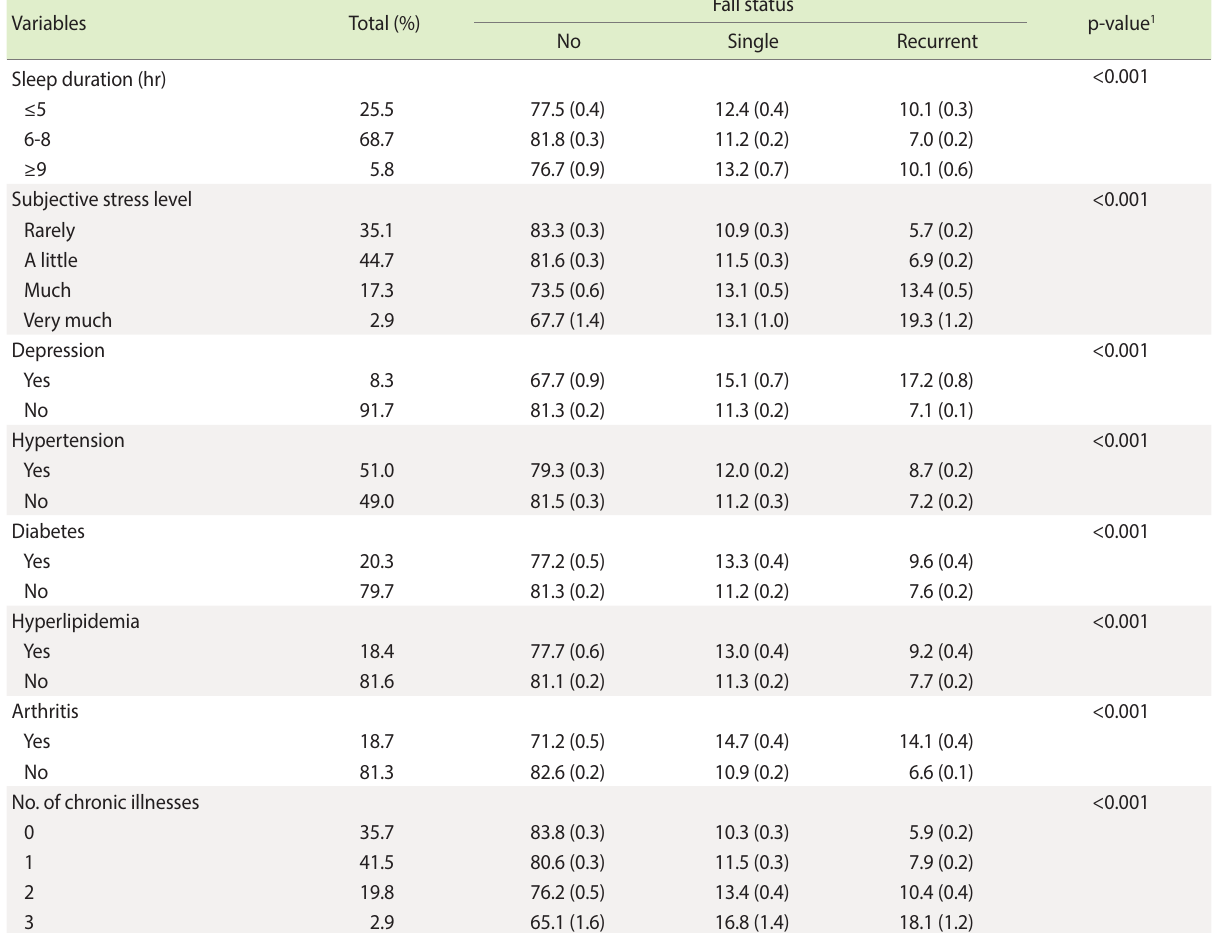
Table 4. Differences in mental health and chronic illness characteristics by fall status in adults aged 65 and